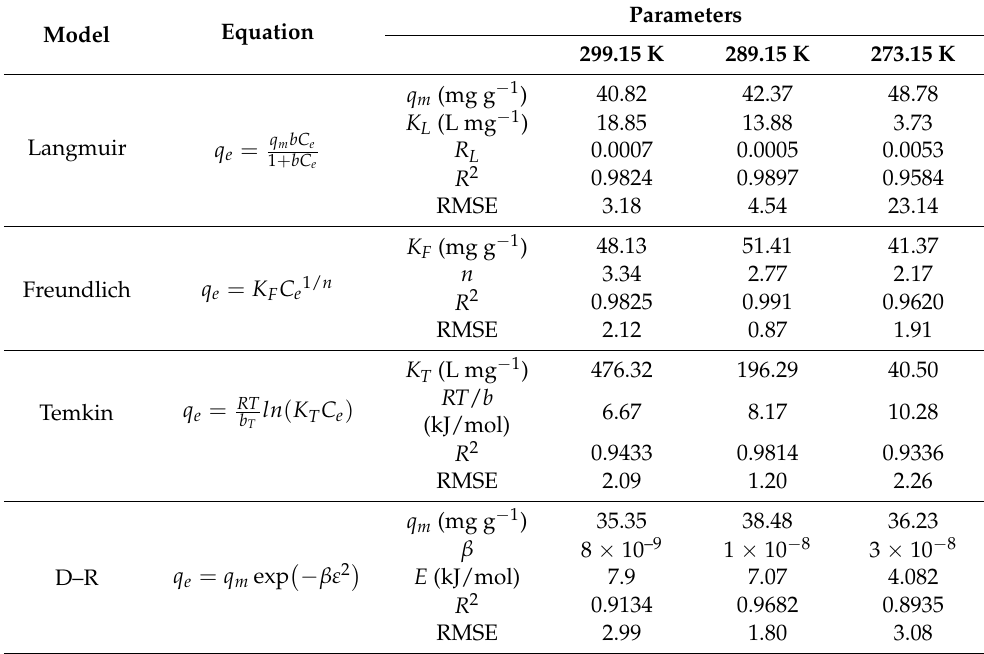
Table 2. The data of equilibrium models studied. Model